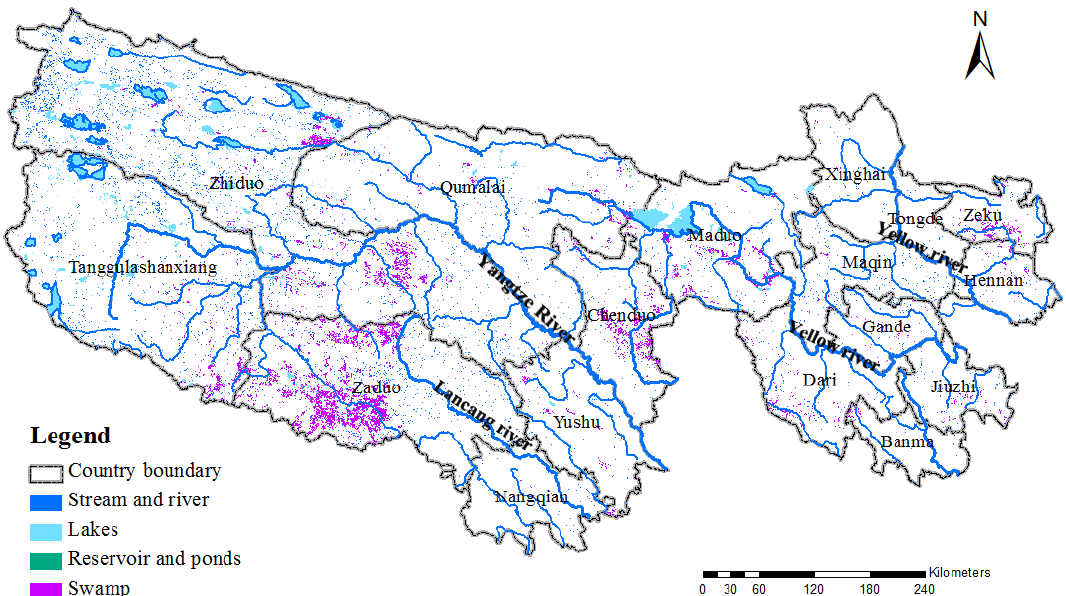
Figure 3. Wetlands distribution in the TRH region in